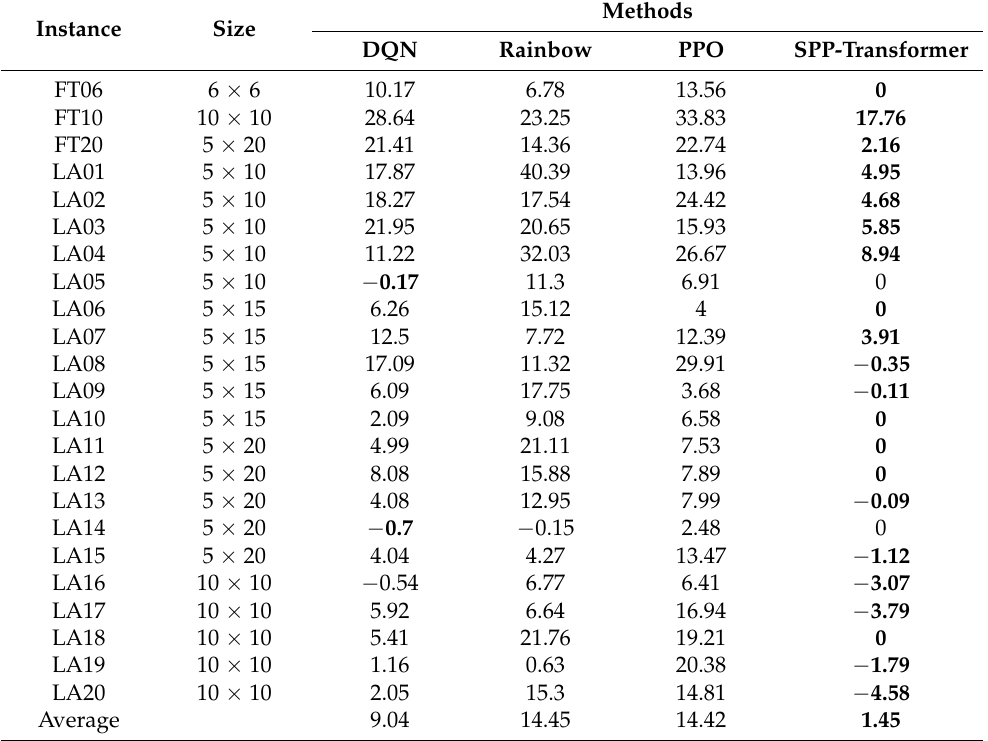
Table A8. The comparison between RL methods and SPP-Transformer on RPD (%).